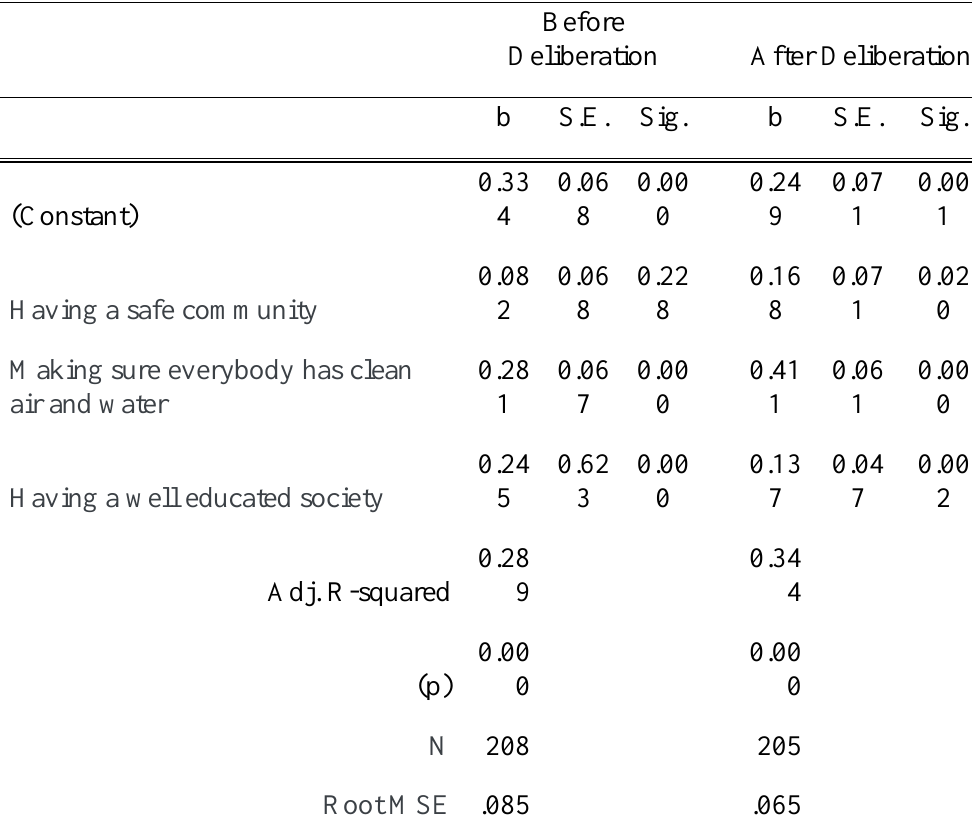
Table 5: Regression: Public Hygiene